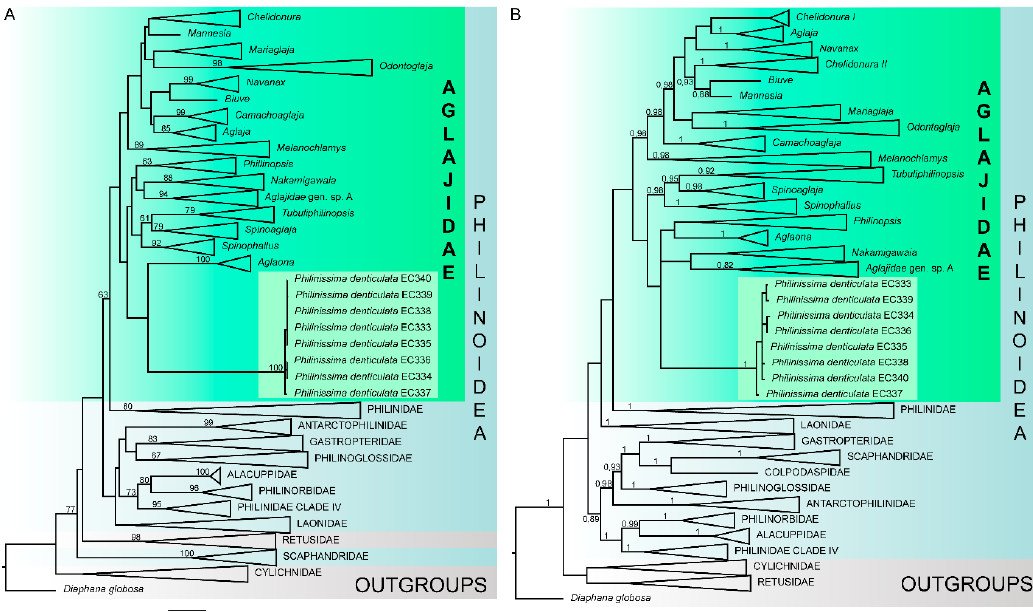
Figure 5. Molecular phylogenetic reconstructions based on a concatenated dataset of four genes (COI + 16S + H3 + 28S). Outgroup clades and genus-level clades within Aglajidae are collapsed. ( A )—Maximum likelihood tree, numbers above branches indicate bootstrap support (only values higher than 60 are shown). ( B )—Bayesian tree, numbers above branches indicate posterior proba- bilities (only values higher than 0.8 are shown).